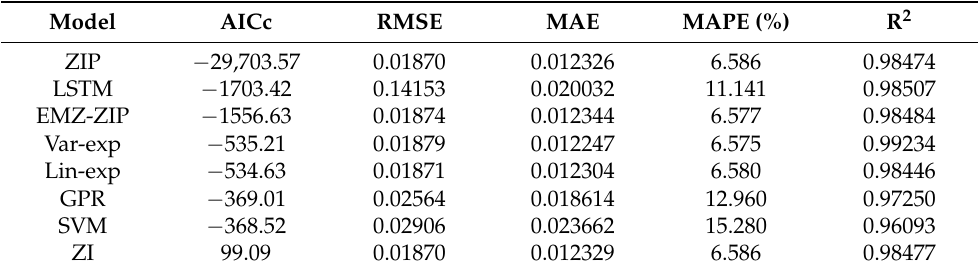
Table 4. Performance analysis